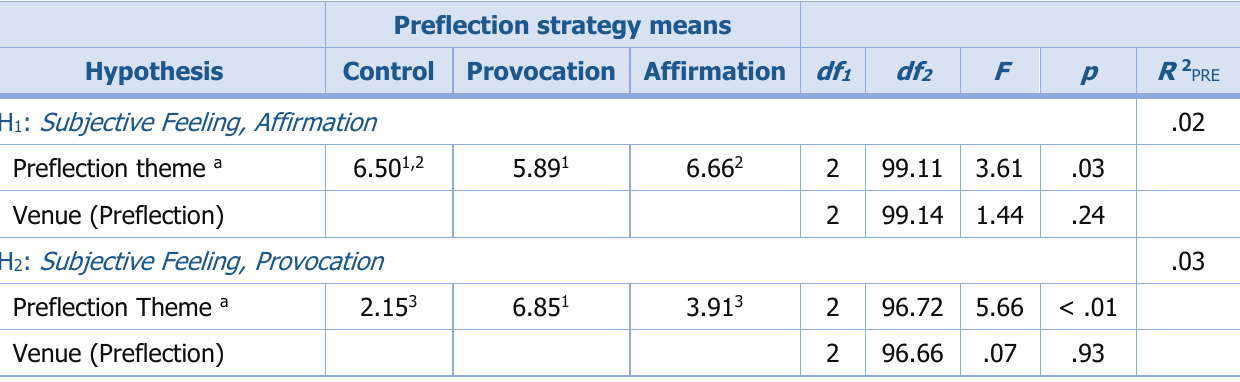
Table 3. Hypothesis Tests: Effects of YPPAR on Feelings of Affirmation and